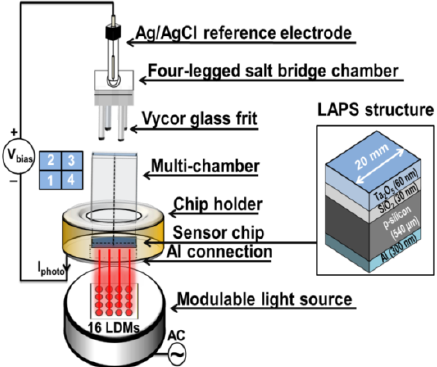
Figure 1. Schematic illustration of the four-chamber di ff erential LAPS measurement set-up, consisting of an Ag / AgCl reference electrode, a PP-ABS four-legged salt bridge chamber (total height 40 mm, leg height 20 mm, Ø legs 4 mm, container area = 15 × 15 mm 2 ) combined with four Vycor glass frits (Ø frit 3.2 mm, height 4 mm) filled with 1 mL KCl solution (3 M), a PP-ABS-based four-chamber structure (sensing area per chamber ≈ 7 × 7 mm 2 , height 20 mm), a chip holder (Ø 40 mm, height 10 mm) made of PEEK, a LAPS chip with Al / p-Si / SiO 2 / Ta 2 O 5 layers, and a light source based on an array containing 16 infrared laser-diode modules (4 per chamber, Ø 3.3 mm, length 7 mm). Chambers 1, 2, and 3 are used as active sensor side with cells. Chamber 4 serves as a reference chamber without cells. The active rear-side illumination area is 15 × 15 mm 2 . I photo : photocurrent, V bias : bias voltage, LDMs: laser-diode modules, AC: alternating current. The measurement photopolymer-based (polypropylene-acrylonitrile-butadiene-styrene, PP-ABS) four-chamber structure combined with a four-legged salt bridge chamber (filled with 1 mL of 3 M KCl solution) and a polymer-based